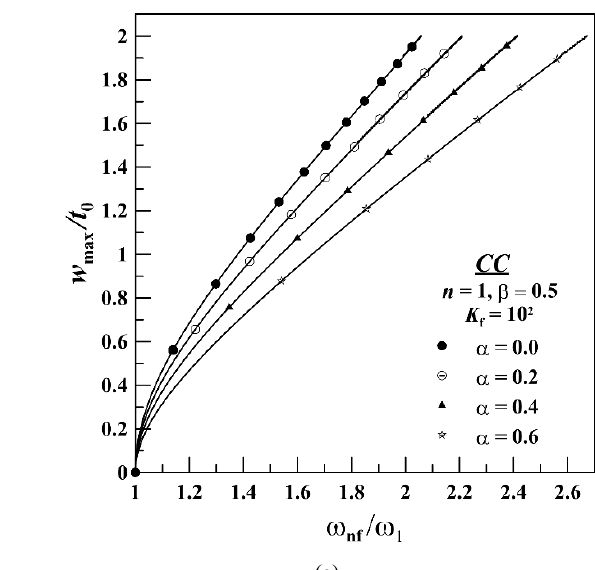
Figure 4. Backbone curves for different values of material gradation index for (a) CC beam, (b) CS beam, (c) SS